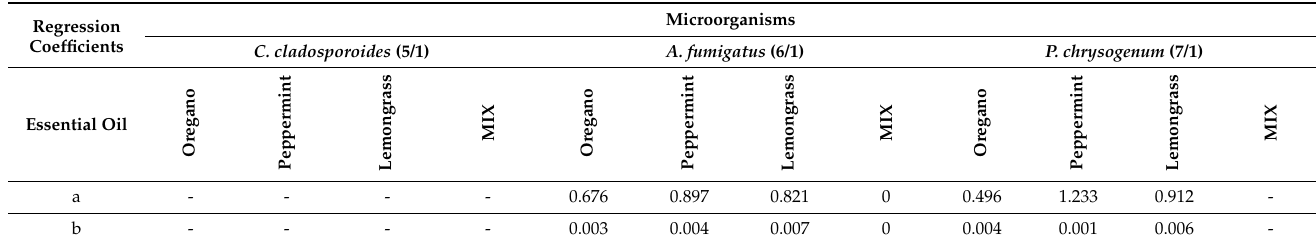
Table 7. Regression coefficients (a and b) for evaluation of EOs’ efficiency in vapour phase.